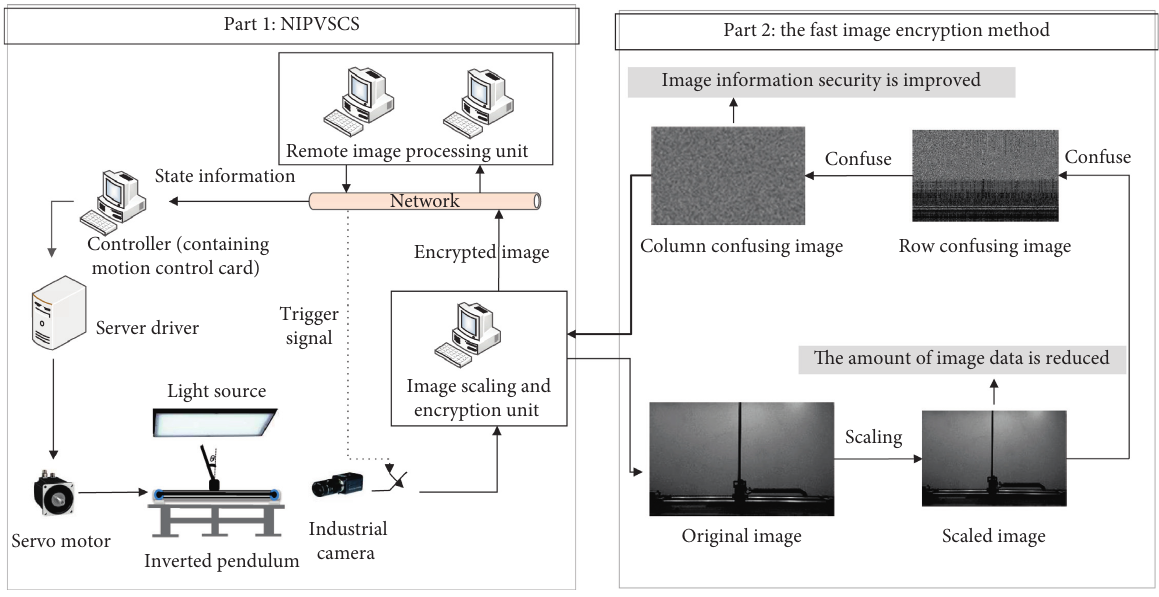
Figure 1: Framework of the